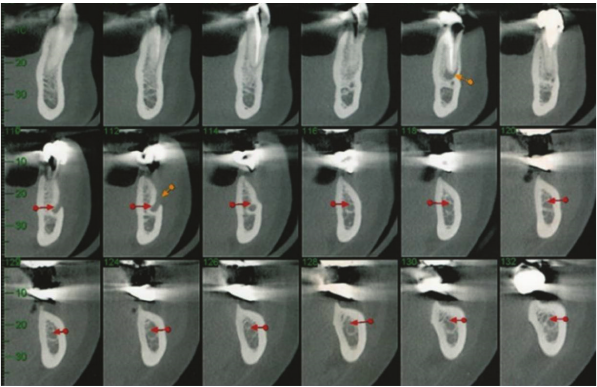
Figure 11: Computerized tomography (cone beam) left jaw.